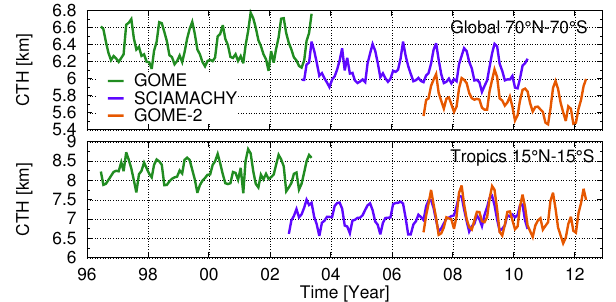
Figure 1. Time series of monthly means of CTH for global (top) and tropical (bottom) region.